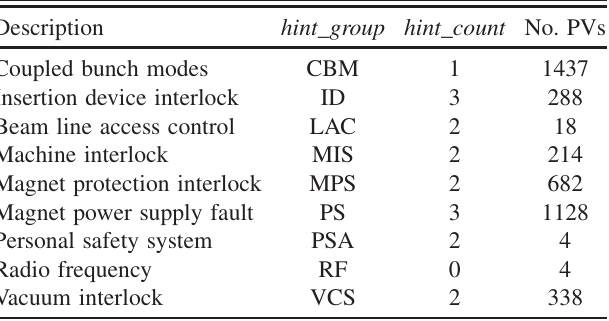
TABLE VIII. The alarm groups at the